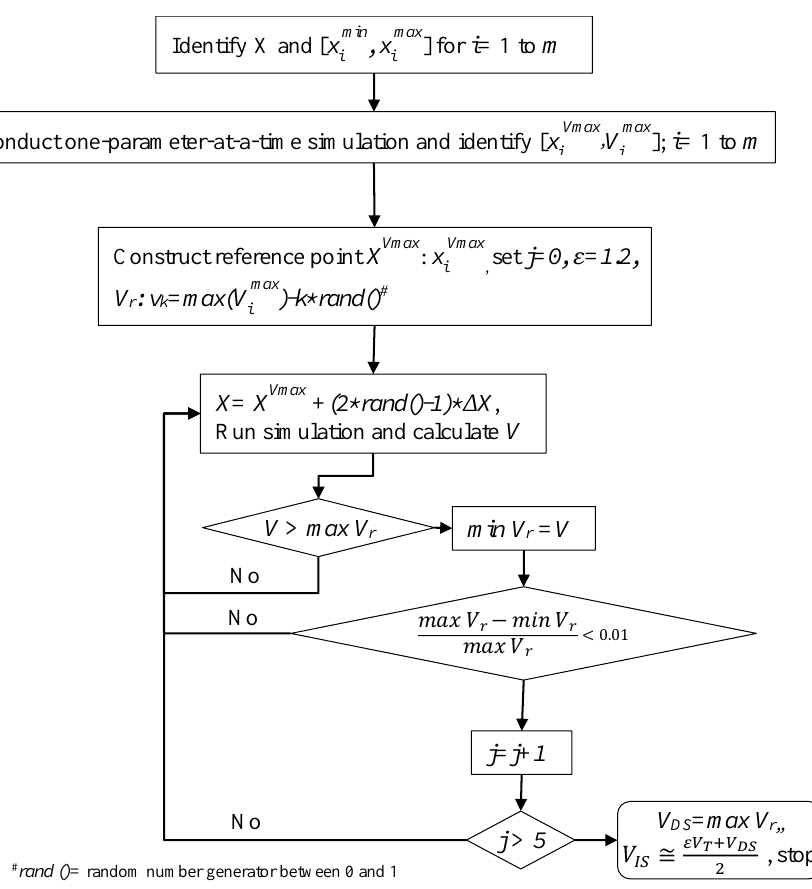
Figure 4. Flowchart for calculation of effective impact velocity ( V IS ).